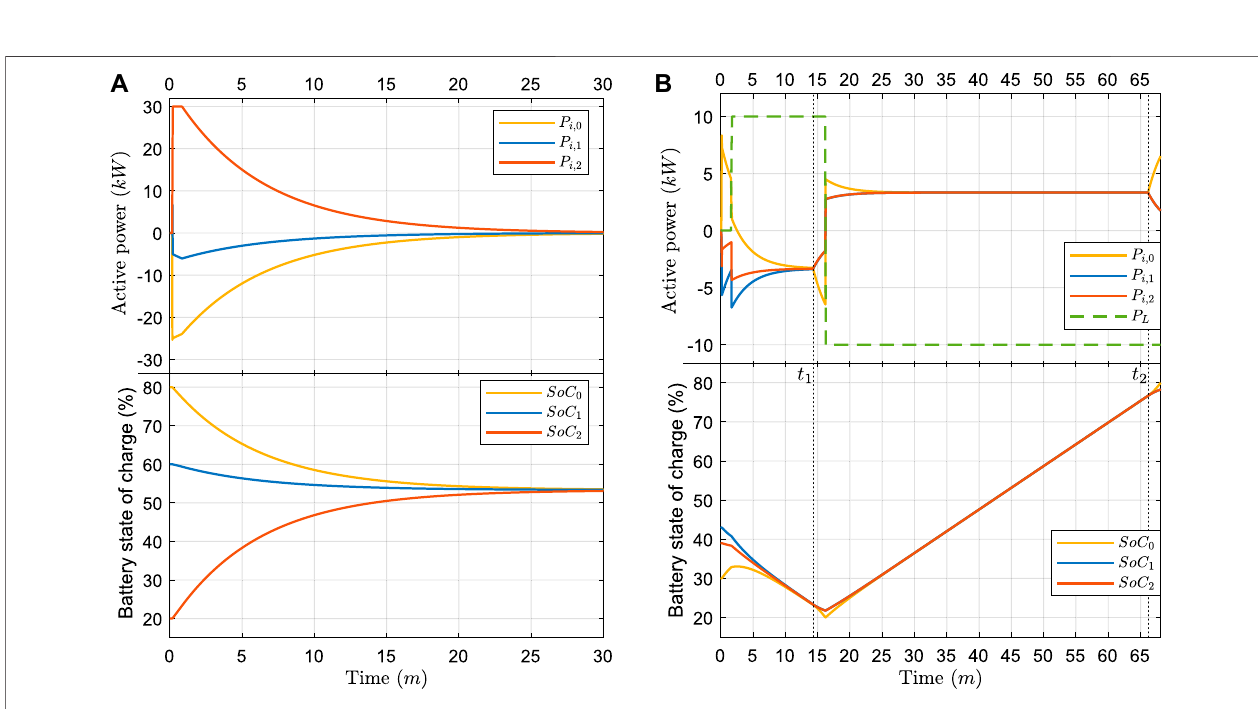
FIGURE 10 | Active power and storage system SoC for test three and 4. (A) test three results with no load and (B) test four results with load power.